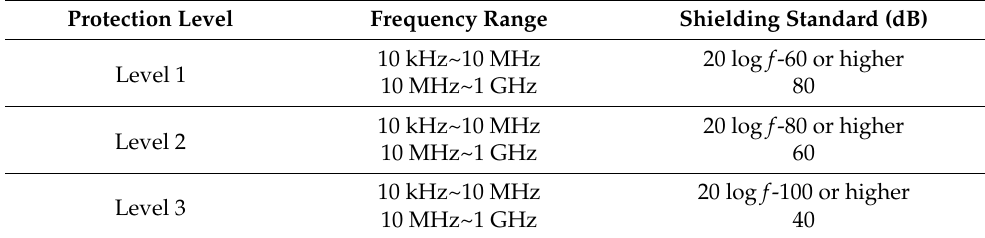
Table 3. Radioactive protection performance